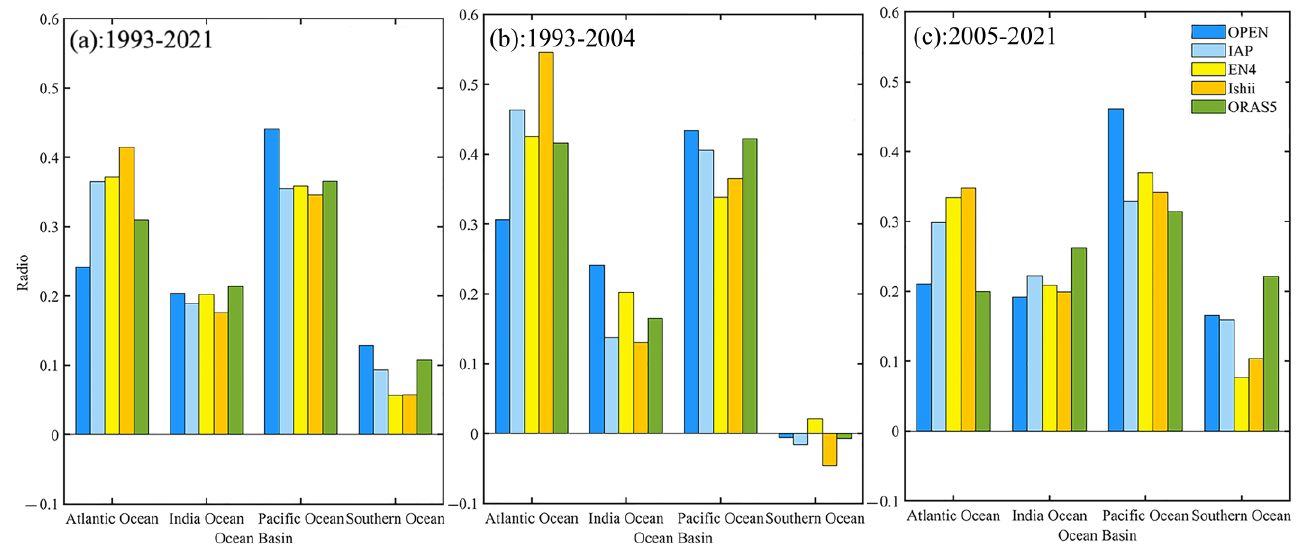
Figure 3. The ratio of heat absorption of the four ocean basins to the global ocean during ( a ) 1993 – 2021, ( b ) 1993 – 2004, and ( c ) 2005 – 2021 was revealed by the five datasets (OPEN, IAP, EN4, Ishii, and ORAS5) with different colors.